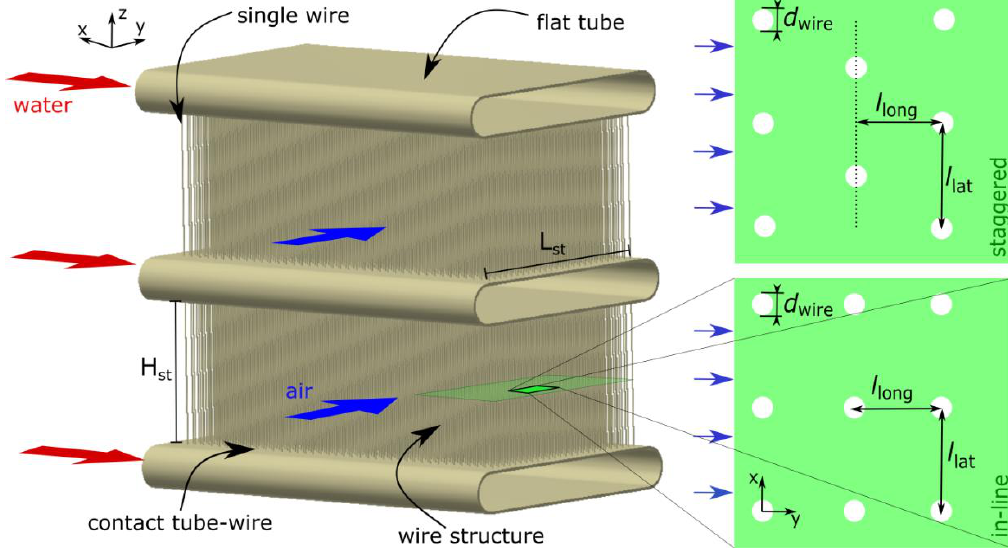
Figure 3. Section of an idealized wire structure heat exchanger with parallel wires between two separating plates; possible design with pin fins and flat tubes ( left ); Arrangement of wires ( right ).